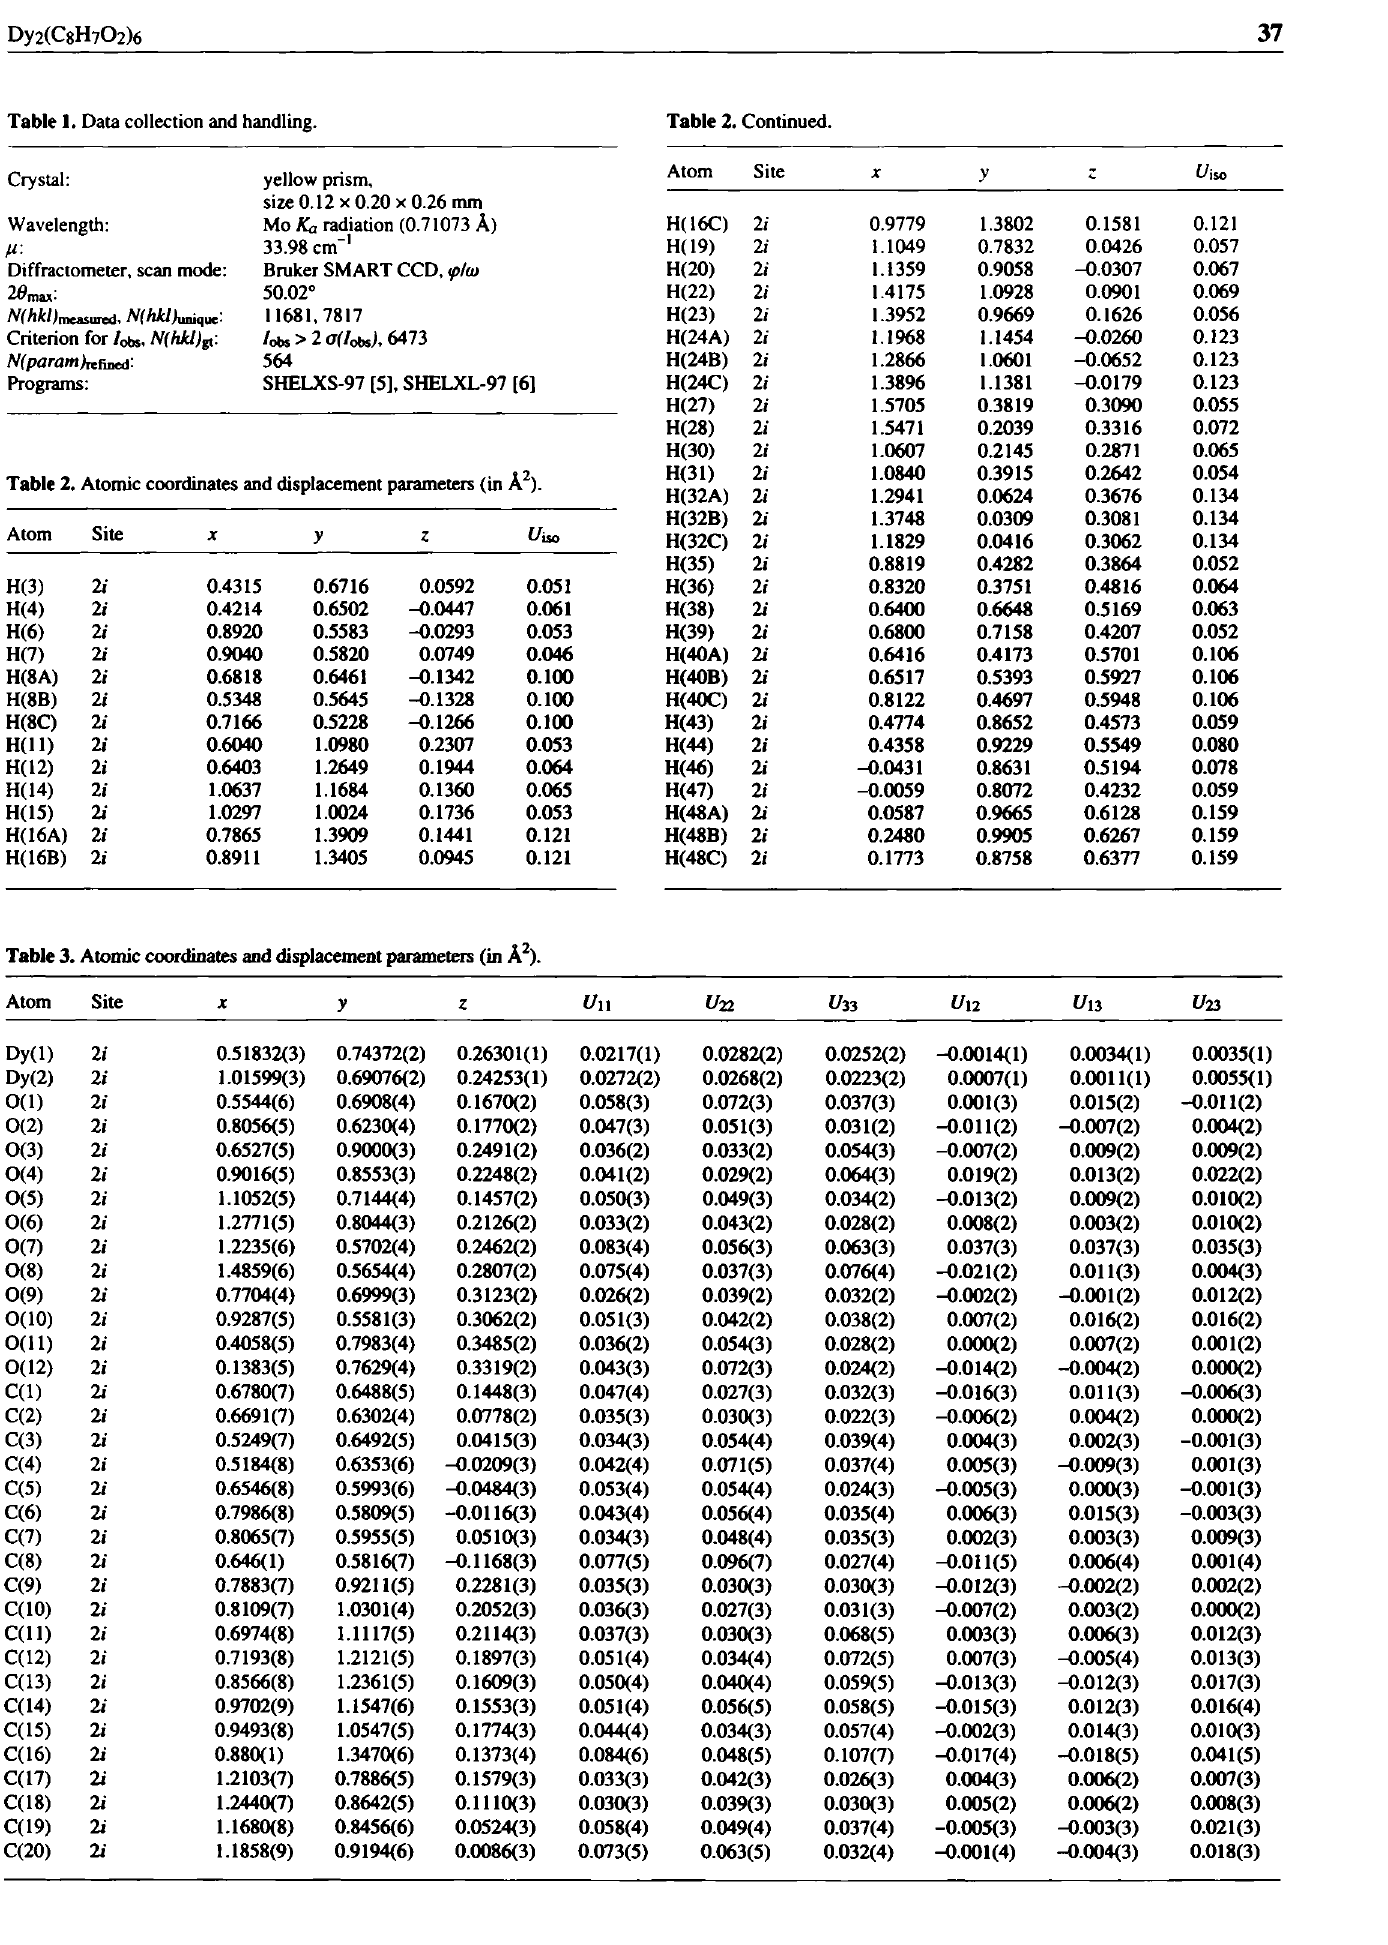
Table 2. Atomic coordinates and displacement parameters (in A 2 ).